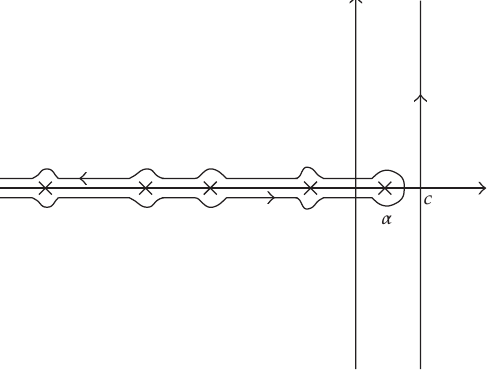
Figure 1: Barnes contour for Mellin